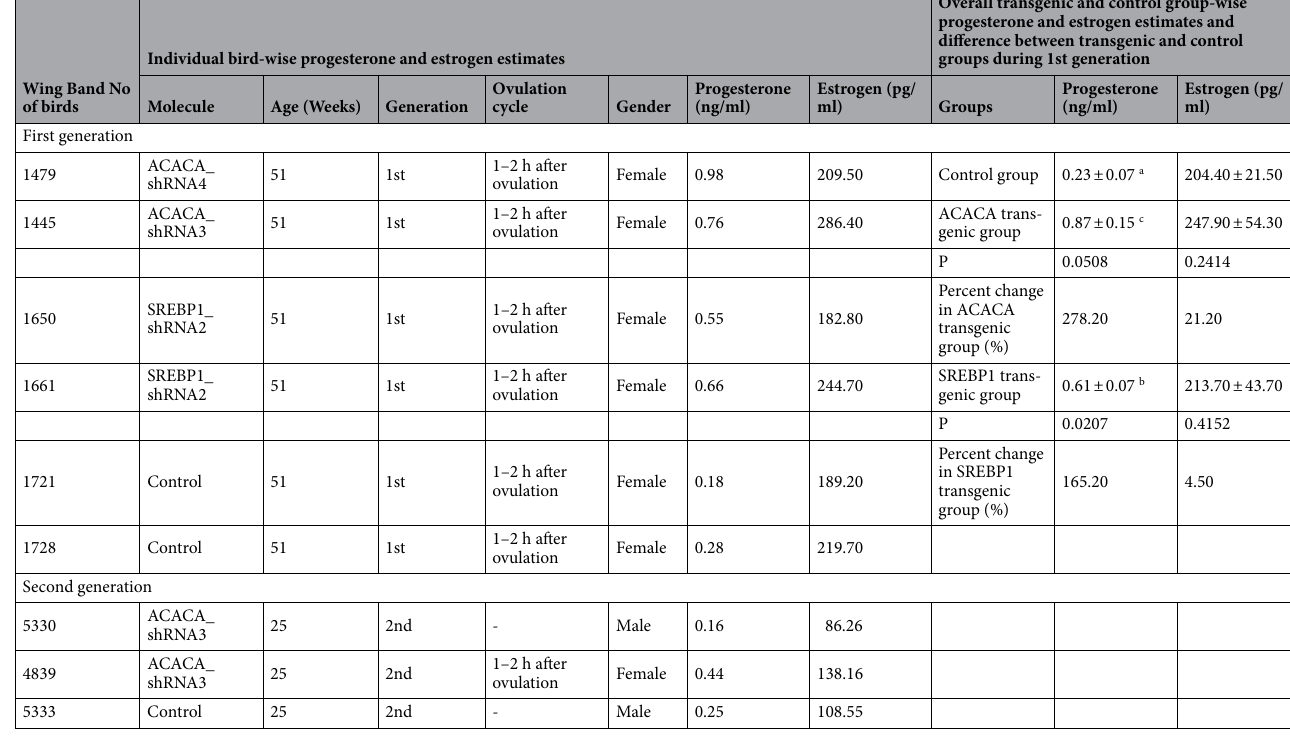
Table 7. Progesterone and estrogen content in serum of adult transgenic and control birds. The hormones were estimated during 1–2 h after ovulation at 51 weeks of age by chemiluminescence immunoassay to compare between transgenic and control groups.